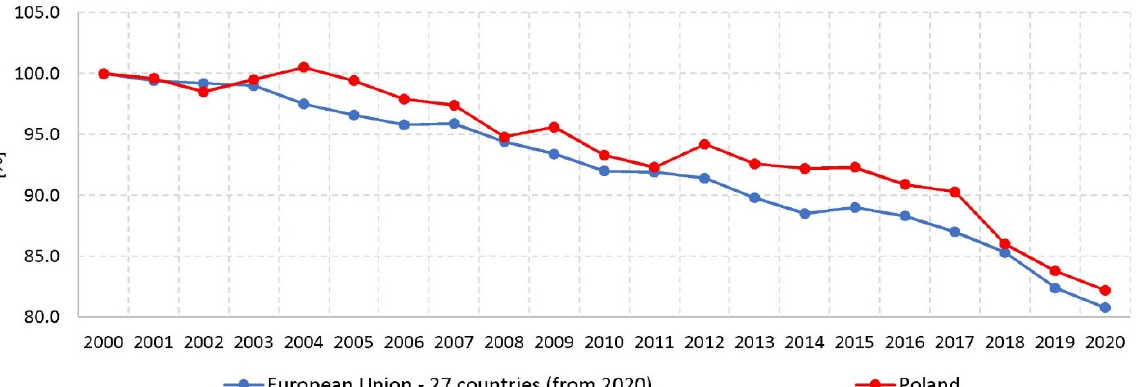
Figure 3. Greenhouse gas emissions intensity of energy consumption. Source: own elaboration based on [27].